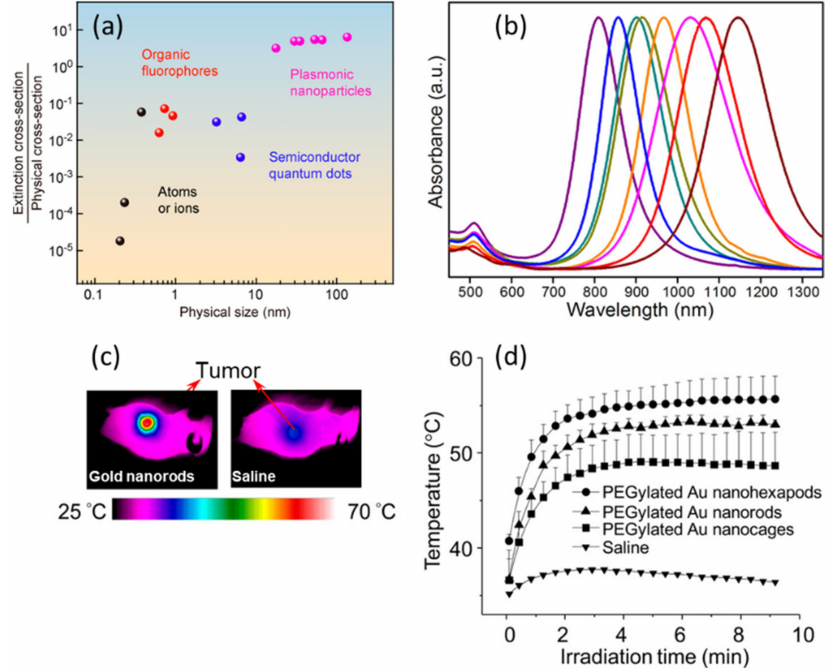
Figure 1. ( a ) Among various types of NPs, metallic plasmonic NPs possess the highest ratio be- tween extinction cross-section and their physical cross-section. ( b ) The longitudinal absorption of gold nanorods can be precisely controlled during the synthesis and can extend towards near